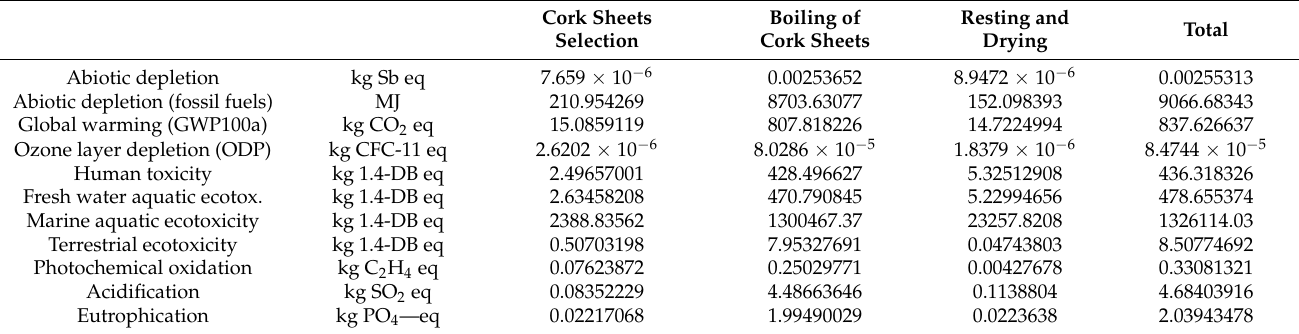
Table 6. Impact of stage 1 broken down by activities for the manufacturing process of 2-piece drilling-perforated stoppers, of 24 mm in diameter and 44 mm in length.